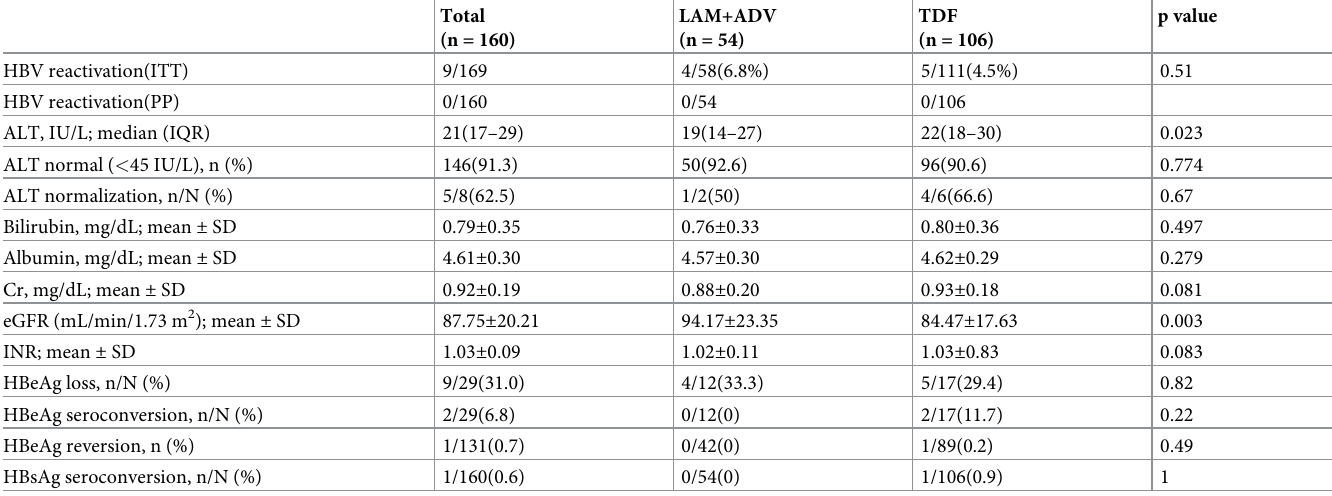
Table 4. Comparison between two groups after 96-week follow-up.